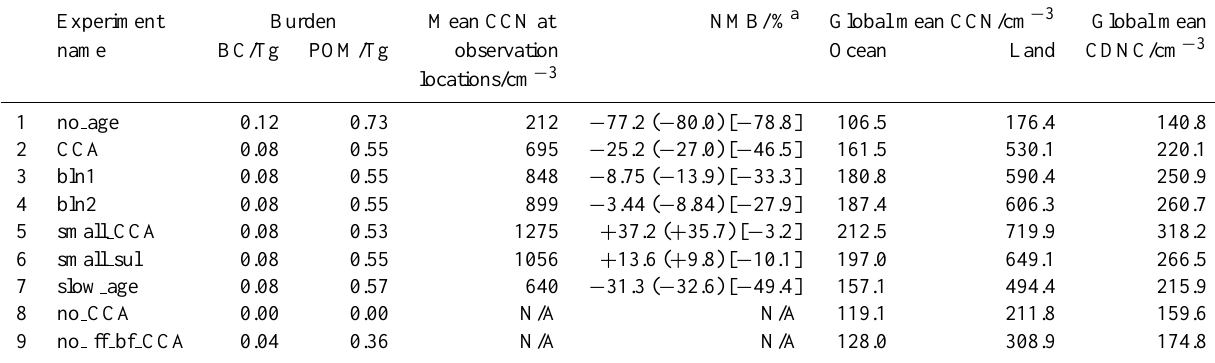
Table 4. Global mass budgets of black carbon (BC) and primary particulate organic matter (POM), mean CCN calculated at same locations and supersaturations ( S ) as the CCN observations listed in Table 1, normalised mean bias (NMB) between model and observations, annual mean surface CCN ( S = 0 . 2%) for oceanic and continental regions and annual global mean cloud droplet number concentration